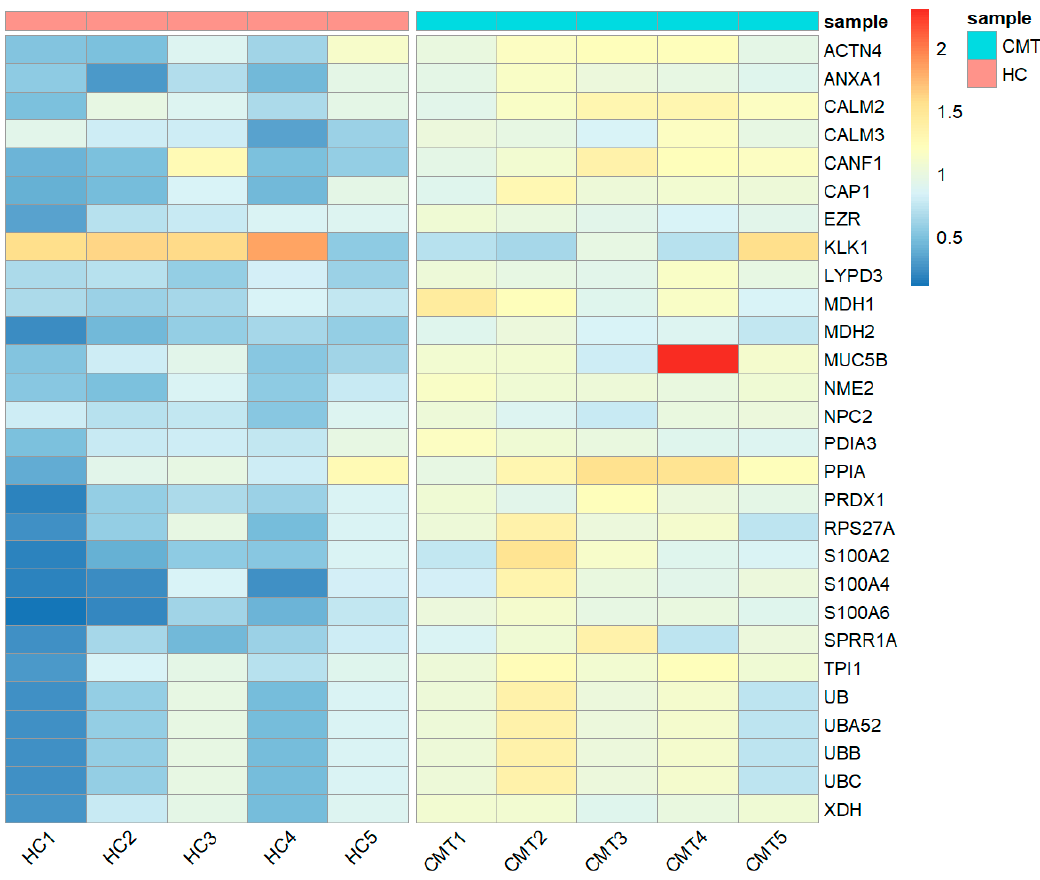
Figure A2. Heatmap showing the relative abundance (color) of salivary proteins in healthy (HC) dogs and dogs with canine mammary tumors (CMT).